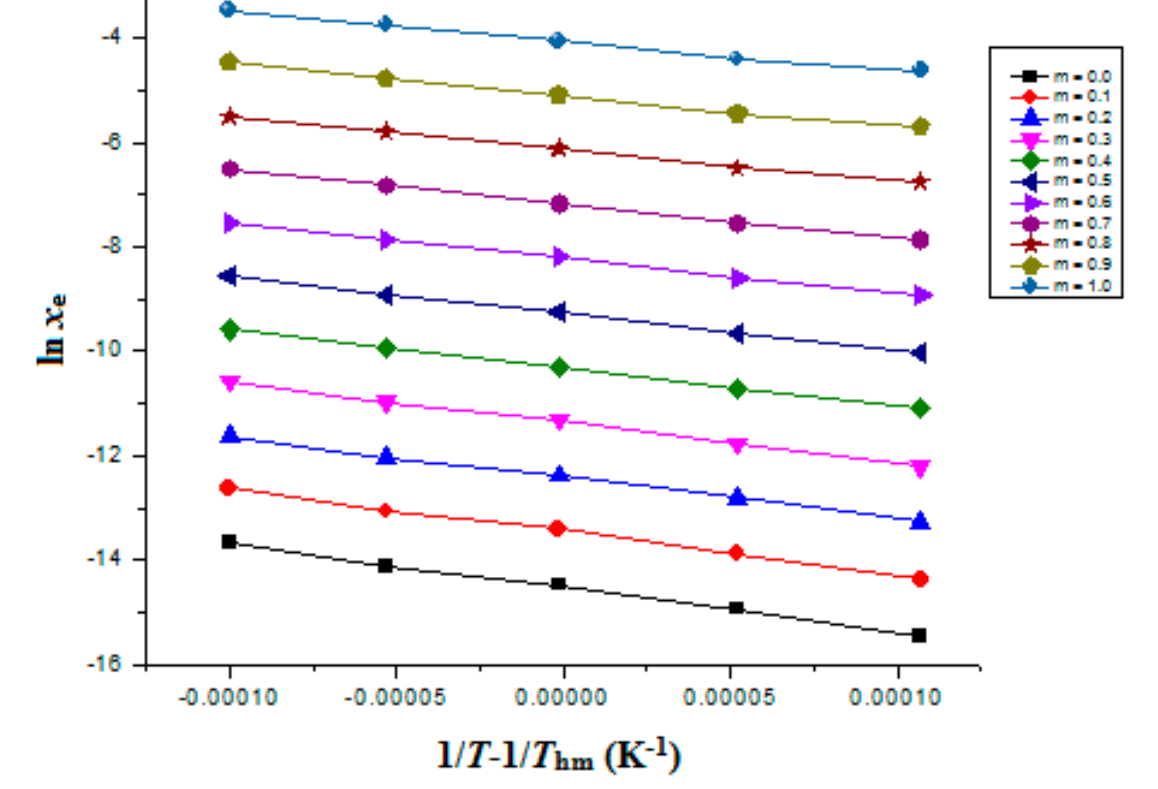
Figure 2. van’t Hoff curves for FXT graphed between ln x e and 1/ T -1/ T hm for FXT in various {PEG 400 (1) + H 2 O (2)} mixtures.